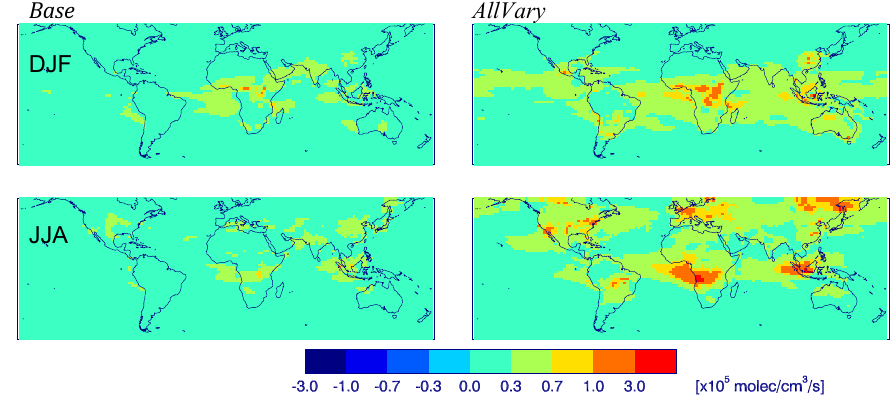
Figure 21. Seasonal mean (1988–2007) standard deviation of tropospheric CO loss rates ( × 10 5 moleculescm − 3 s − 1 ) from the Base (left column) and AllVary (right column) scenarios.